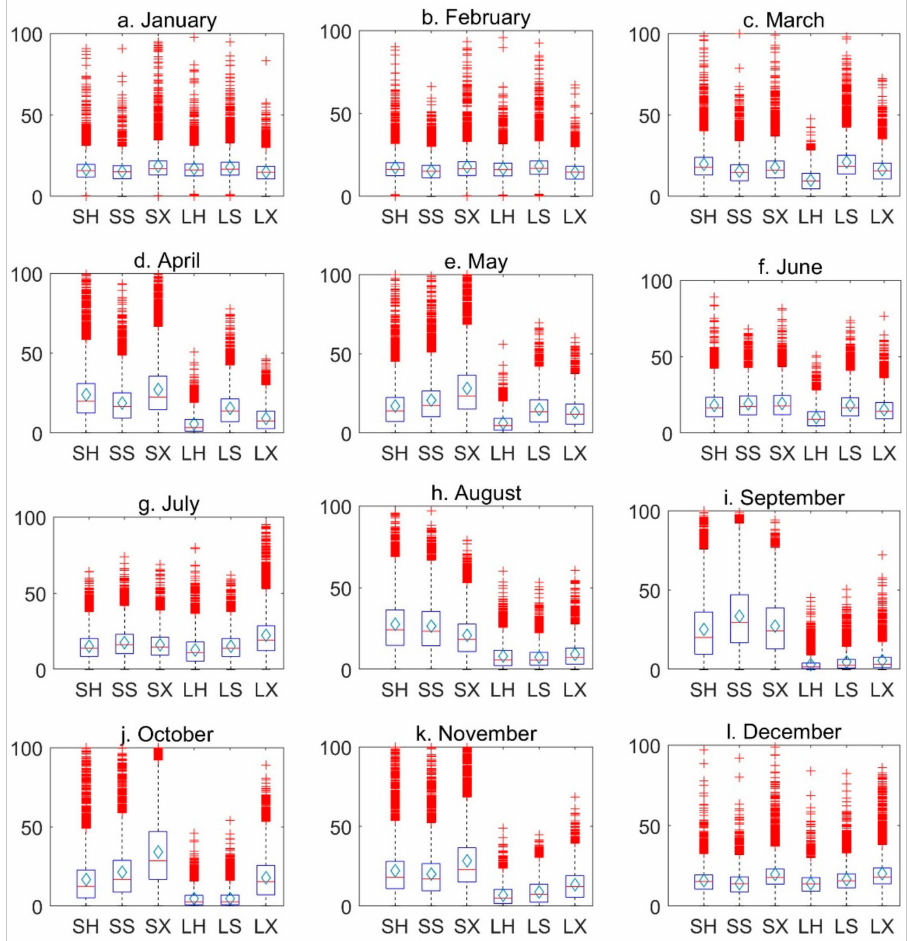
Figure 11. Same as Figure 7 but for minimum monthly